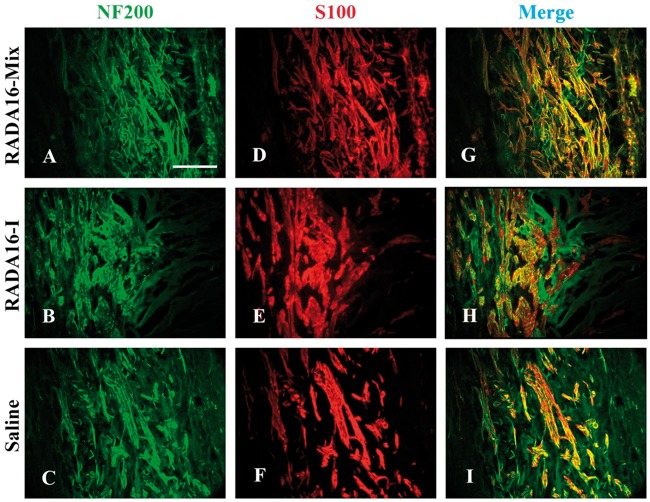
The longitudinal sections of the middle position 8 weeks after implanting different grafts. The axons were labeled by NF200 in green and Schwann cells were labeled by S100 in red. Scale bar: 200 μm.